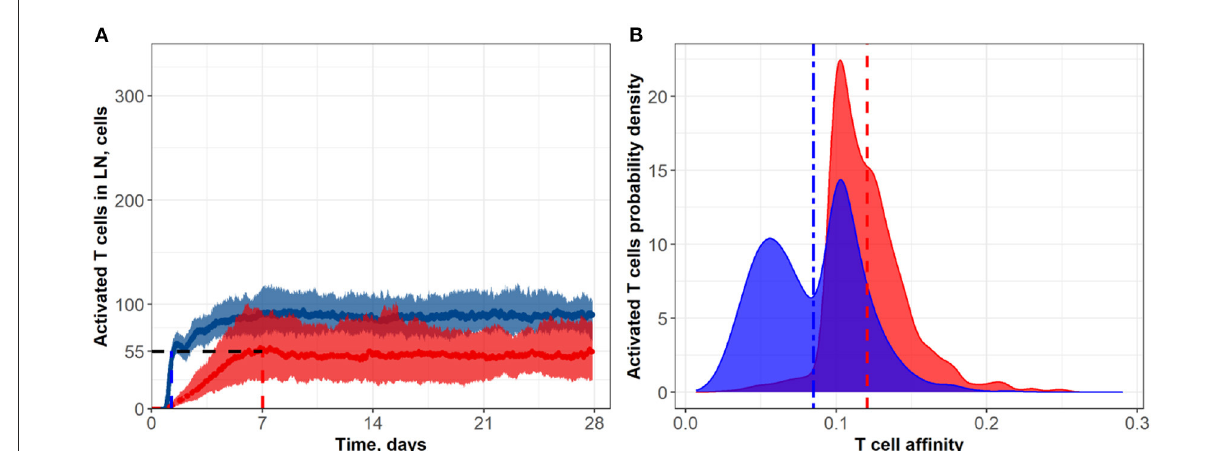
FIGURE3 (A) Population dynamics of activated T cells in the LN T zone during immune response initiation: Control conditions (red) and after administration of an anti CTLA-4 blocking antibody (blue). (B) Affinity distributions of activated T cells: Dotted vertical lines represent mean affinities for control and anti CTLA-4 conditions. Scenarios used different affinities corresponding to a 50% priming probability K prime : 0.1 (blue; anti CTLA-4 blocking antibody) and 0.2 (red; control). Corresponding data files are available at the free repository GitHub at: https://github.com/ Potamophylax/ABM_anti-CTLA-4/tree/main/Numerical%20Results/Hypothesis%20I.